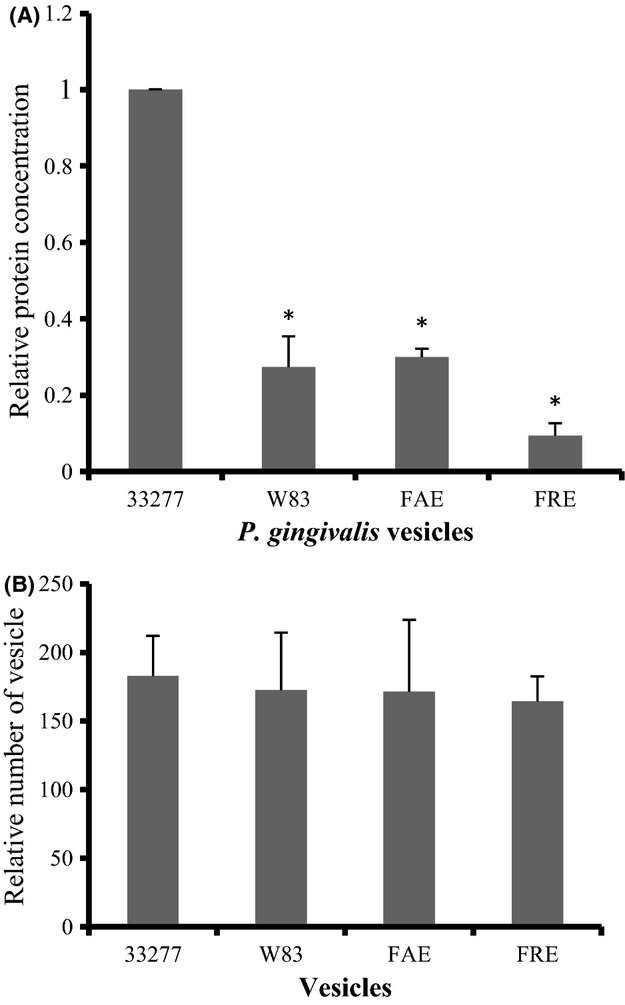
Comparison of vesicle production from Porphyromonas gingivalis strains. Vesicles were isolated from the 30 mL of growth media for P. gingivalis 33277, fimA mutant (FAE), fimR mutant (FRE), and an afimbriated strain (W83). (A) Protein concentrations of vesicle suspensions were determined using a Bio-Rad Protein Assay Kit, and each bar presents the relative protein concentrations of vesicles isolated from each P. gingivalis strain compared to that of P. gingivalis 33277 (as 1 unit). Error bars represent standard deviations (n = 3). An asterisk indicates a significant difference between the protein concentration of vesicles of a given P. gingivalis strain compared to P. gingivalis 33277 (*P < 0.05 by t-test). (B) Equal amounts of vesicle suspensions were determined by averaging the number of vesicles in 10 electron microscopic images. Each bar presents an average of the number of vesicles in an area of 5.6 × 5.6 μm.